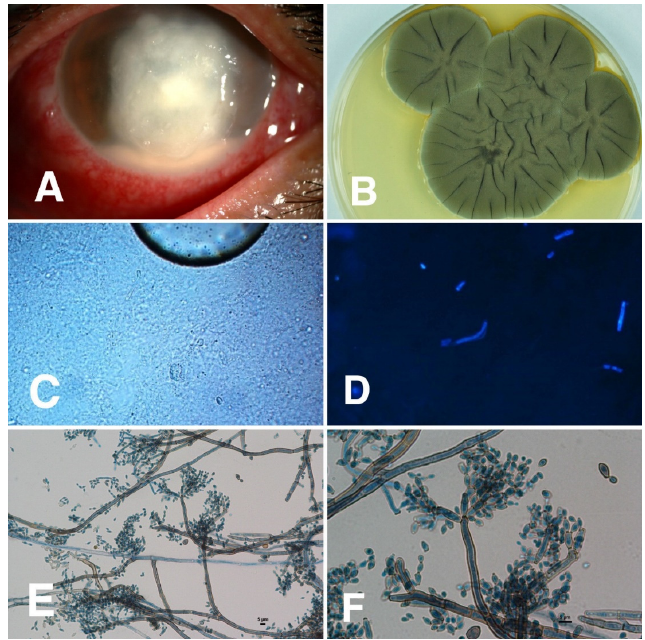
Figure 4. Clinical characteristics of Cladosporium keratitis and microbiological identification from corneal scraping specimens. ( A ) Cladosporium keratitis showing both feathery edge and hypopyon; ( B ) cultivation on Sabouraud’s dextrose agar at 28 °C shows grayish-green velvety colony; ( C ) 10% KOH mount showing fungal hyphae, magnification 400; ( D ) fluorescent microscopic picture was taken after calcofluor white staining, magnification 400; ( E , F ) microscopic examination of the slide culture showing conidia with scars, at 100 and 400 magnifications.